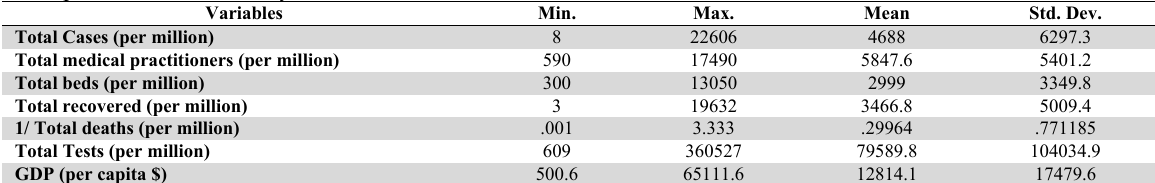
Descriptive statistics summary of the data